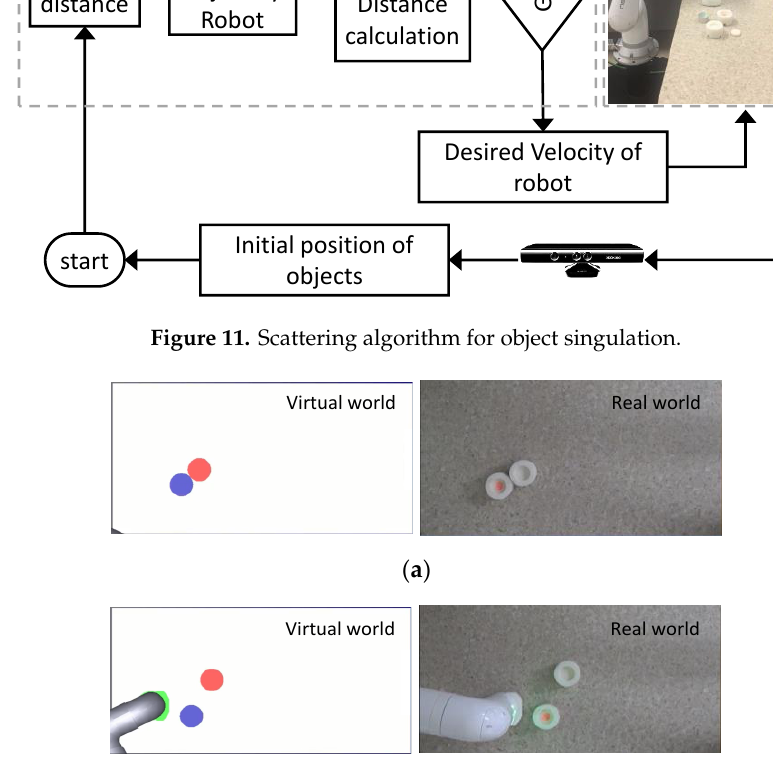
Figure 12. Scattering experiments for singulation of two objects: ( a ) before collision; ( b ) after collision. Manipulator velocity: 0.4 m/s.